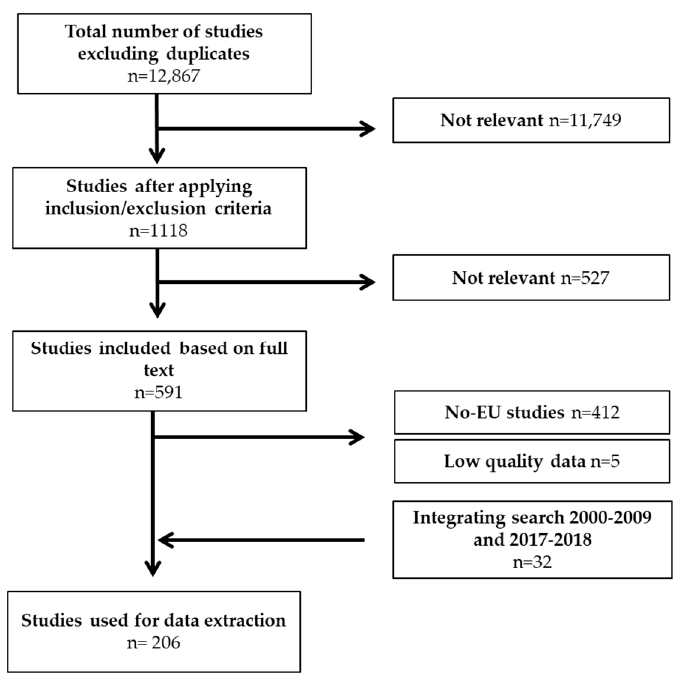
Figure 1. Flow chart of the extensive literature search performed.